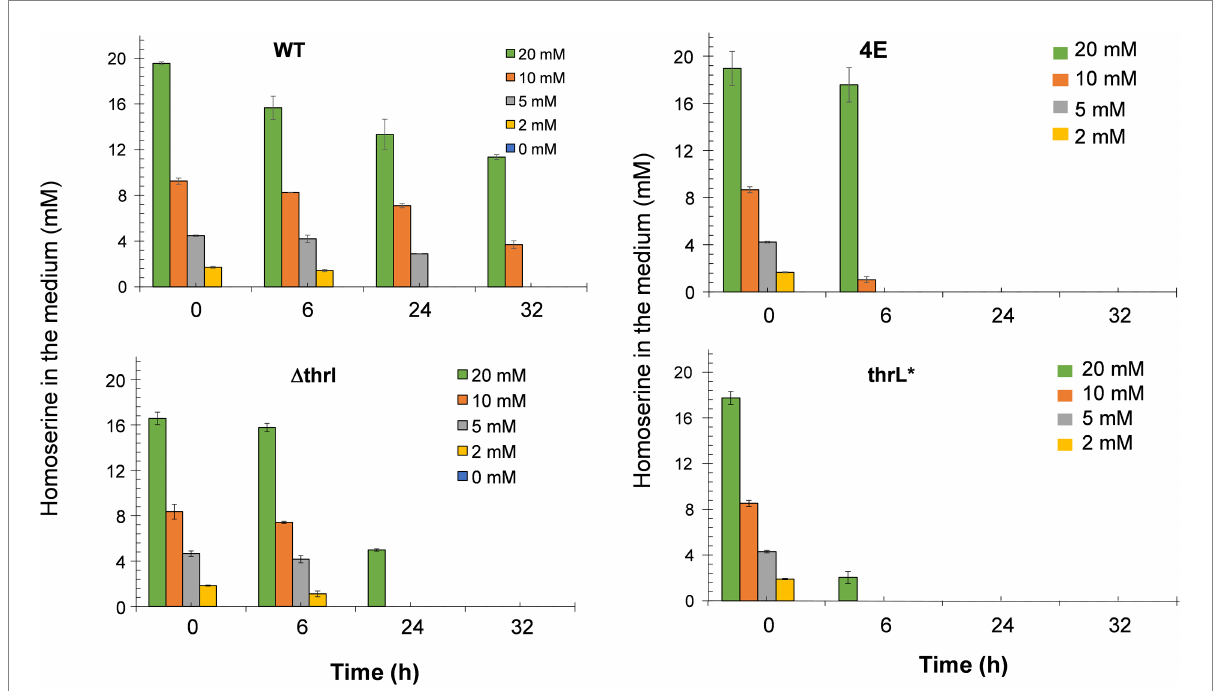
FIGURE 4 Fate of exogenous L-homoserine in MG1655 (WT), MG1655 deleted for thrL ( Δ thrL), MG1655 in which thrL was replaced by thrL * (thrL*) and homoserine-adapted strains (4E) during batch growth in M9 mineral medium with 2% (w/v) glucose at 37 ° C. Data are the mean of three biological replicates and the SD is represented by bars on the histograms.